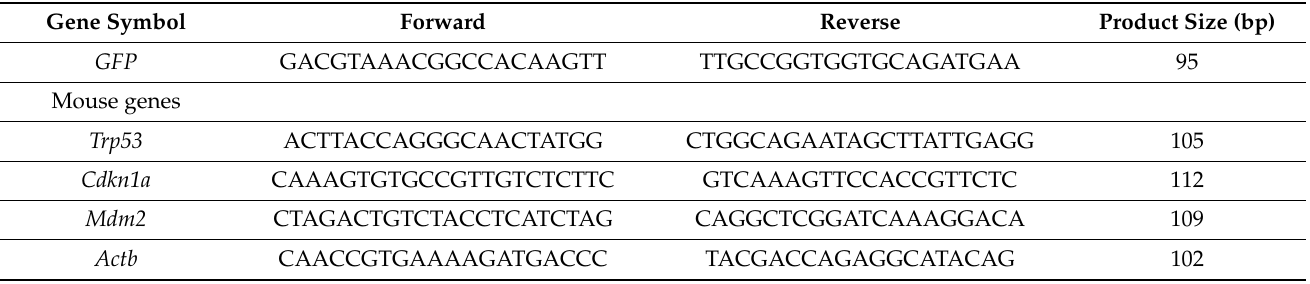
Table 1. Sequences of primers and predicted product sizes for real-time RT–PCR